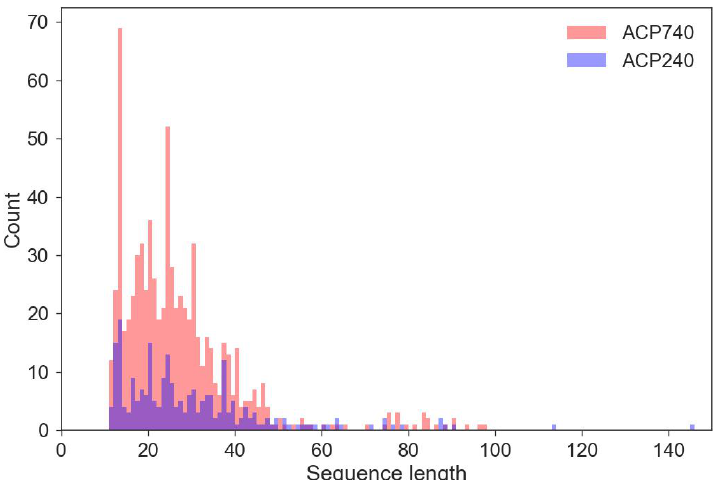
Figure 5. Histogram of the sequence length of peptides in ACP740 and ACP240